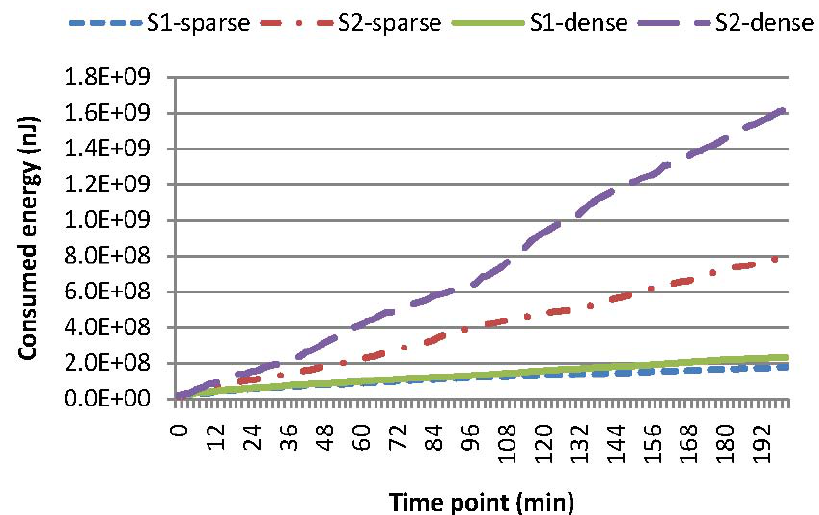
Figure 7. Comparison of the accumulated energy consumption for single-attribute query in a sub-region (SAQSR) with various query configurations, where S1 - sparse means the sparse sub-regions with our cache mechanism, S2 - sparse means sparse sub-regions without our cache mechanism, S1 - dense means the dense sub-regions with our cache mechanism and S2 - dense means the dense sub-regions without our cache mechanism. The gradient of the curves represents the ratio of energy consumption for answering the query. This figure shows that the energy consumption is decreased dramatically when our cooperative caching mechanism is adopted, especially when the sensors nodes are densely deployed in the network. For instance, 348% (or 599%) more energy is consumed for the case of S2 - sparse (or S2 - dense ) than the case of S1 - sparse (or S1 - dense ).